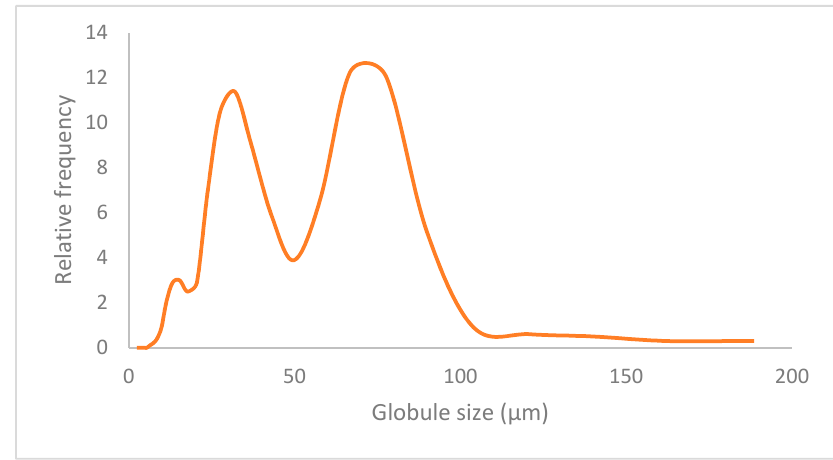
Figure 3 . Particle size distribution of water in oil in water (W/O/W) double emulsion with a W/O emulsion to WPI ratio of 1:1.333.